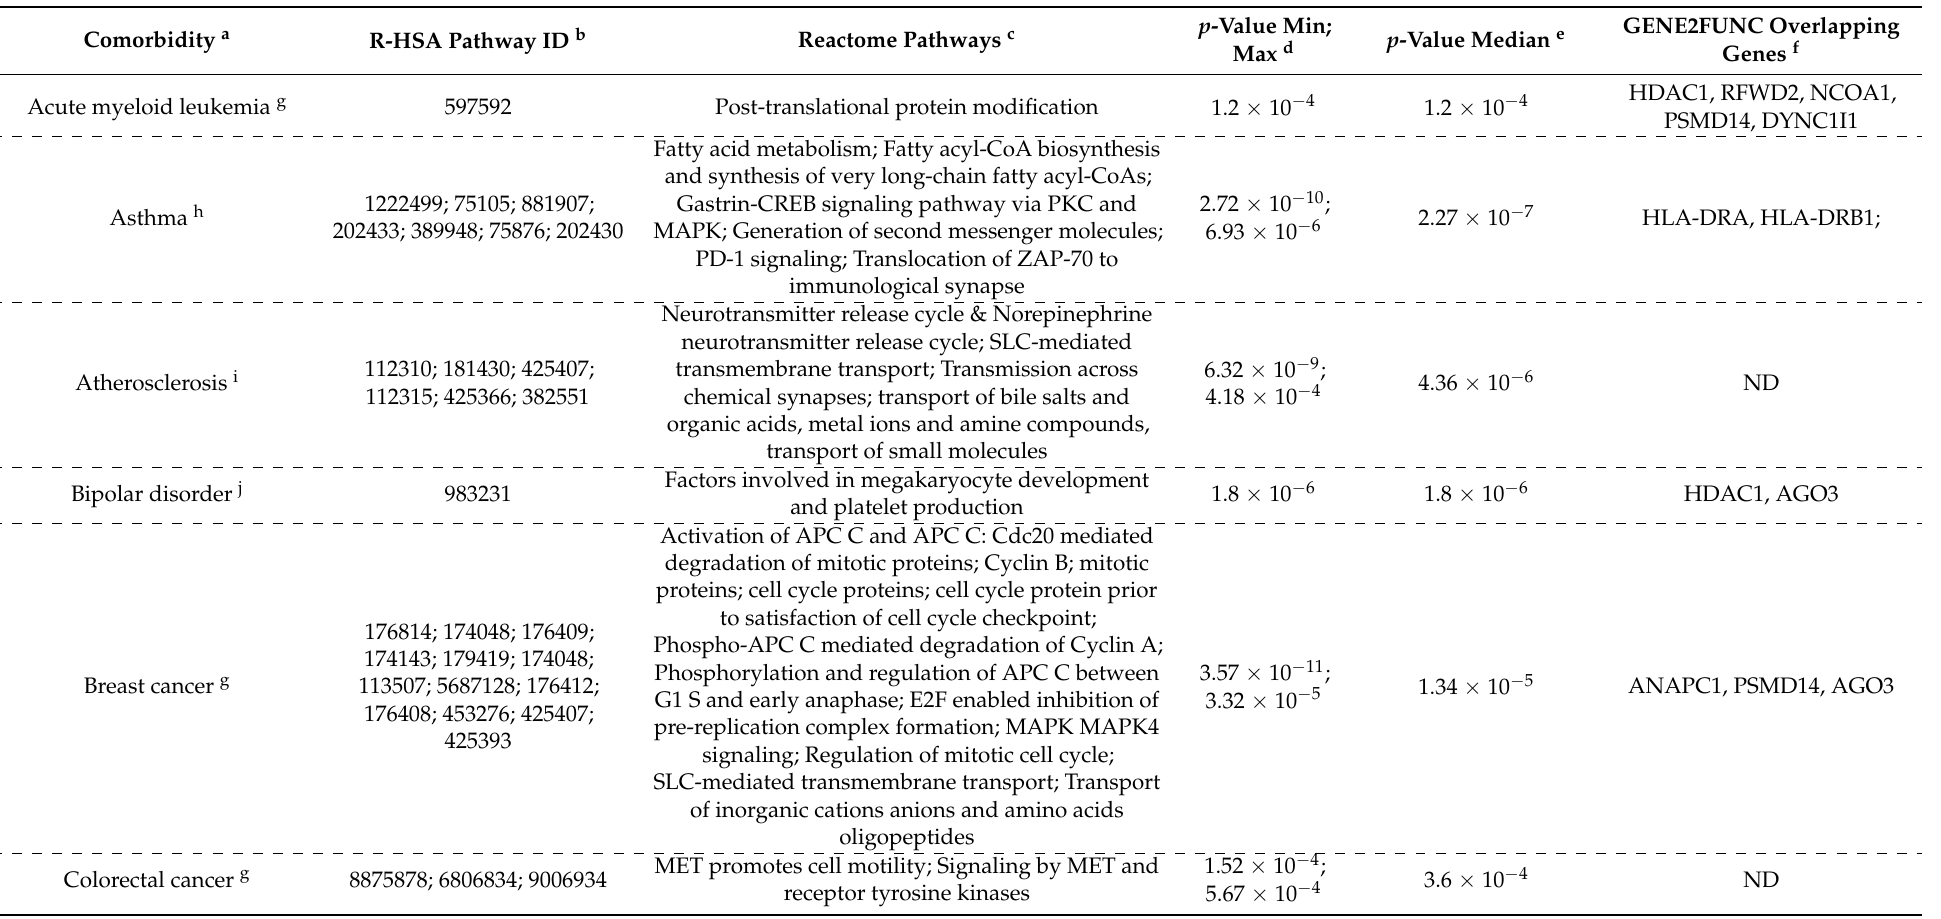
Table 2. Reactome significant COVID-19 comorbidity-associated pathways from EnrichmentMap program via MAGMAv1.07b. (a) SARS-CoV-2 infection-related possible comorbidity name having significant pathways and genes analyzed using MAGMAv1.07b ( n = 22). (b) Reactome pathway unique identifier; (c) Reactome pathway name, (d) p-value minimum and maximum; (e) p-value median; (f) Genes overlapping in Gene Sets via Functional Mapping and Annotation of Genome Wide Association Studies (FUMA GWAS) GENE2FUNC online tool (https://fuma.ctglab.nl/, accessed on 4 January 2021) results. Comorbidities: (g) Cancer (non-head and neck cancer) group ( n = 9), (h) Respiratory group ( n = 2), (i)